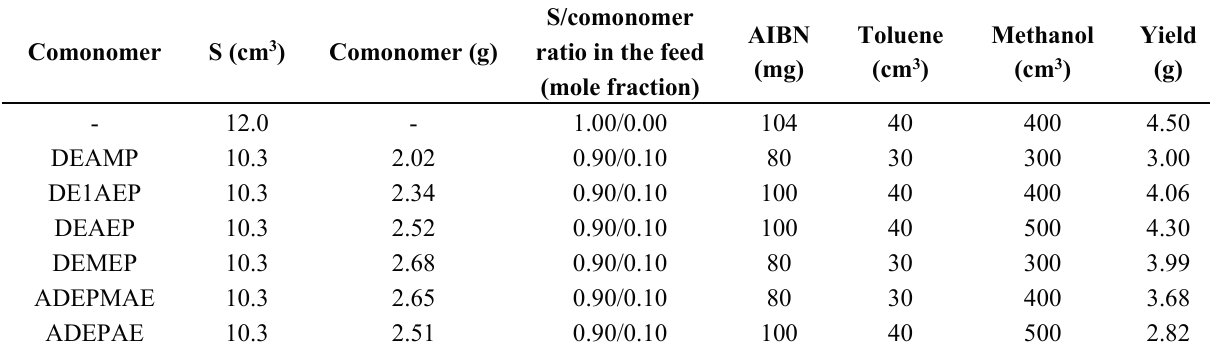
Table 3. Preparative data for styrene (S)-based polymers.